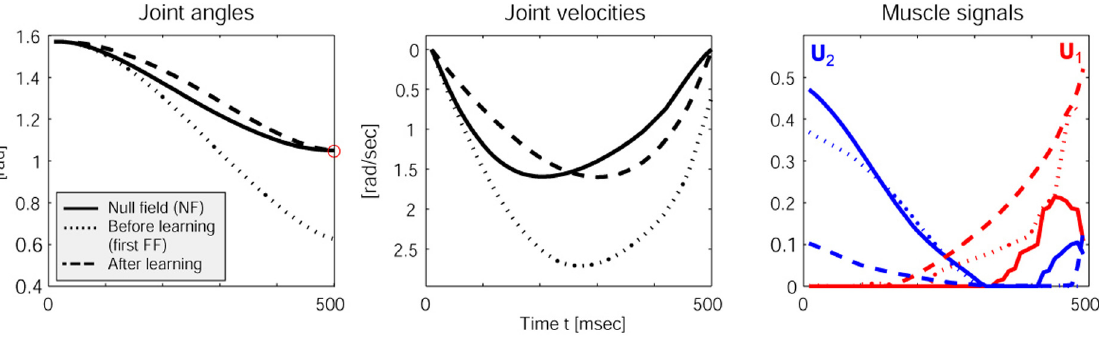
Figure 6. Optimal reaching movement, before, during and after adaptation. Clearly the solution is being re-optimized with the learned dynamics (including the FF).